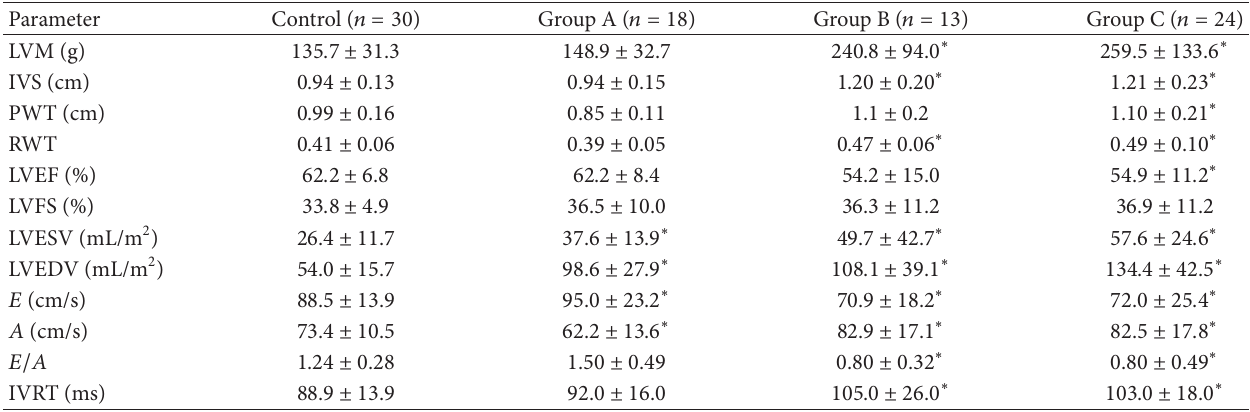
Table 2: Echocardiography results in ADPKD patients.